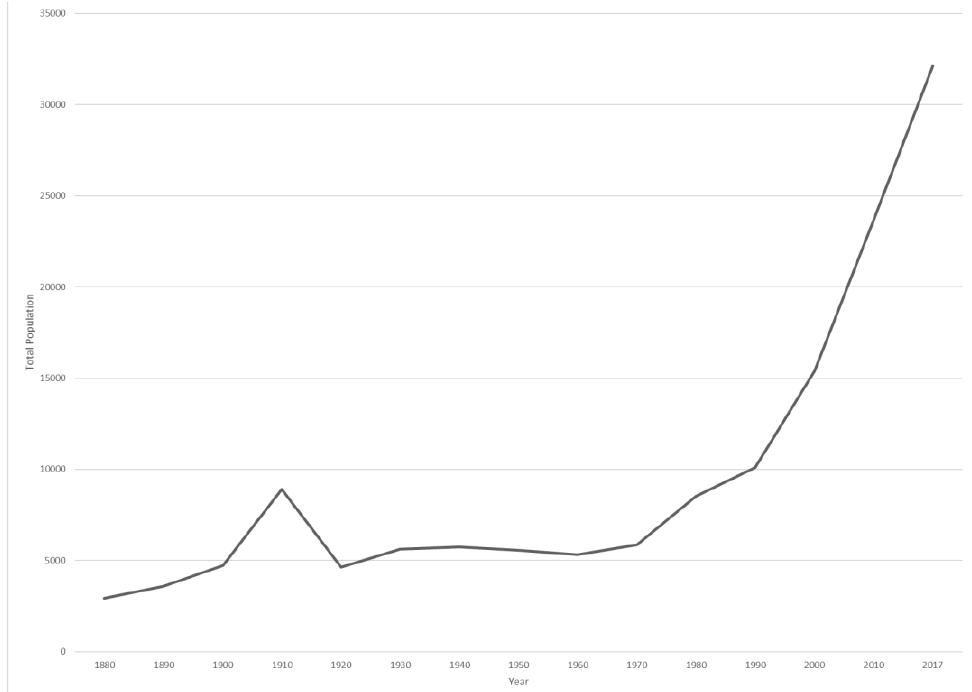
Figure 3. Historical population growth in Wasatch County.